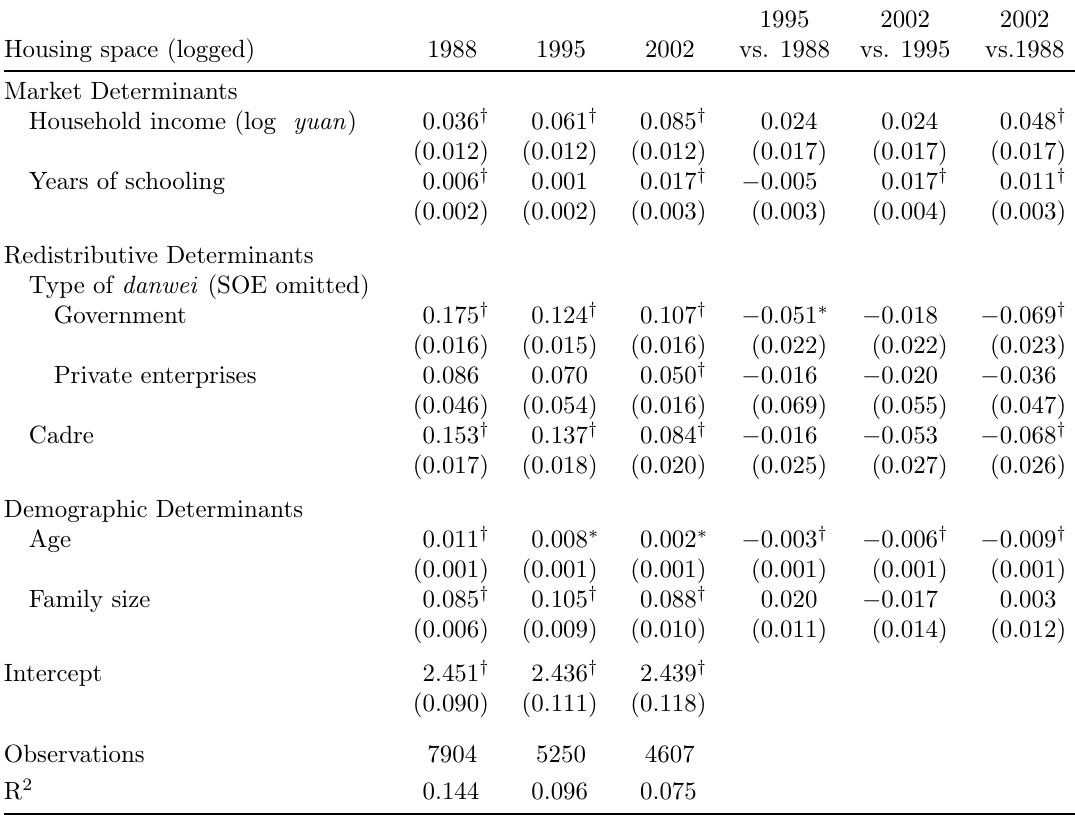
Table 3: Changing Determinants of Housing Space without Regional